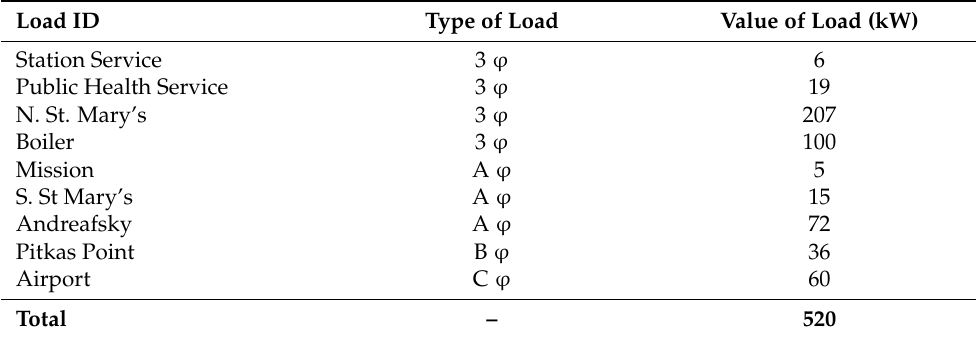
Table 1. Used Load Values for Simulations.